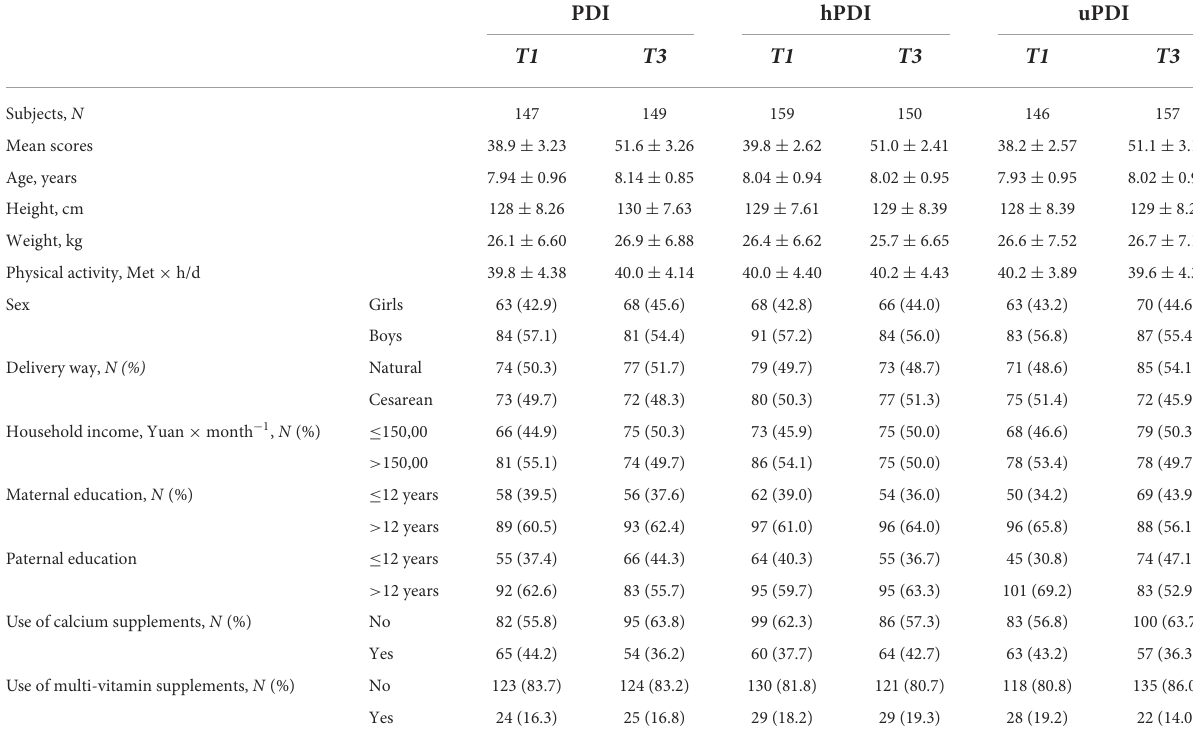
TABLE 1 Characteristic of subjects included in the